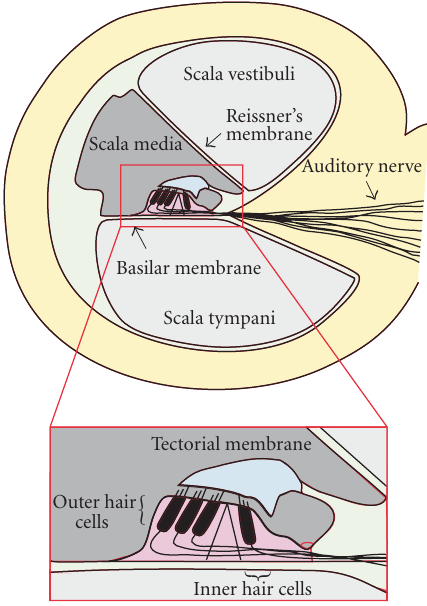
Figure 2: A cross-section of the human cochlea. Within the bone are three fluid-filled chambers that are separated by two mem- branes. The input to the cochlea is in the scala vestibuli, which is connected at the apical end to the scala tympani. Pressure di ff er- ences between these two chambers lead to movement in the basilar membrane. The scala media is isolated from the other two cham-